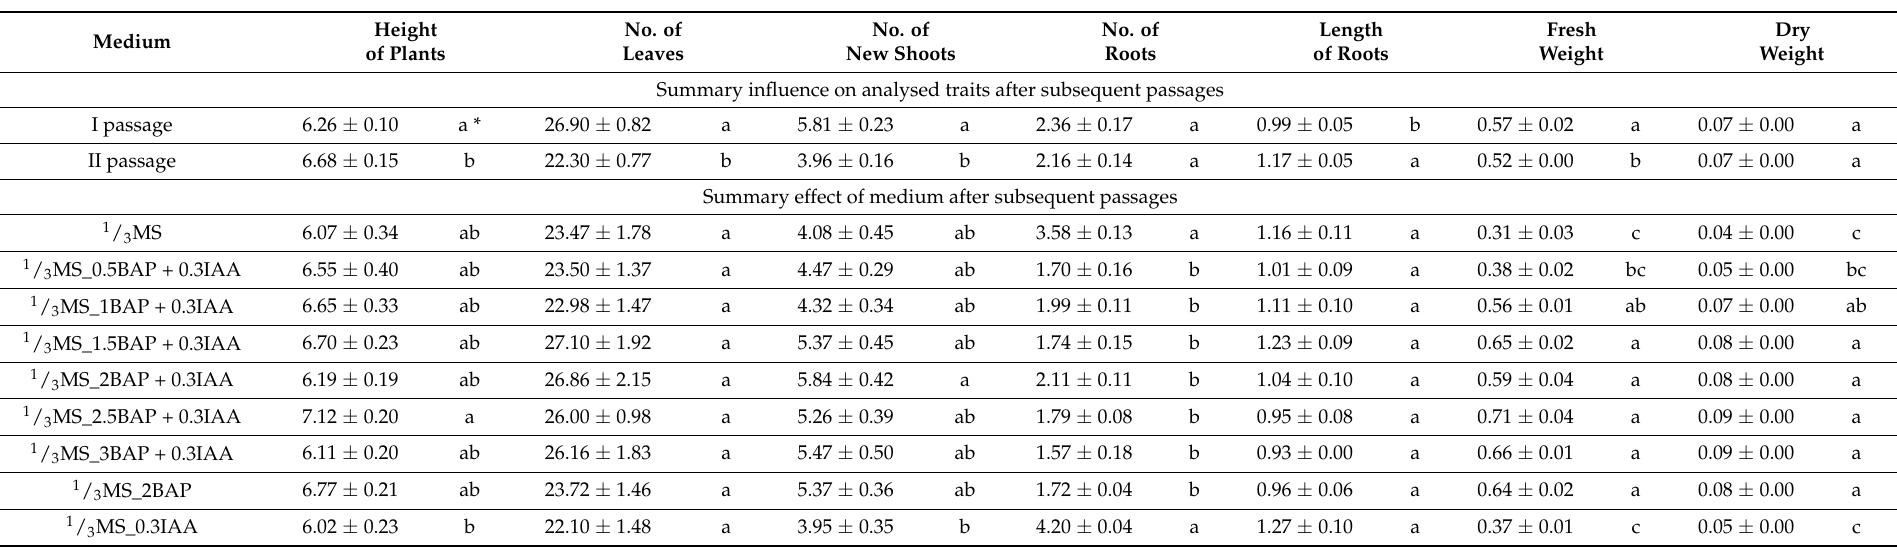
Table 1. Influence of subsequent passages and medium composition on the development of Sarracenia alata